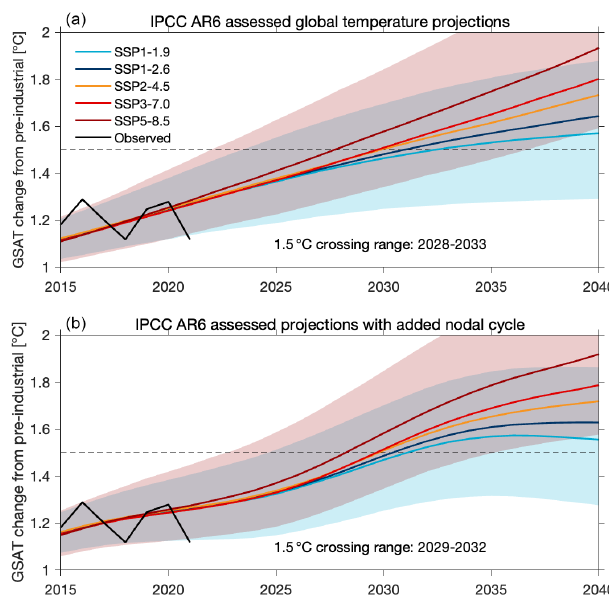
Figure 10. (a) IPCC AR6 assessed trends in GSAT (global sur- face air temperature) for different Shared Socioeconomic Pathways (SSPs). (b) As panel (a) but with a lunar nodal cycle of 0.04K am- plitude, chosen to be approximately an average of the constant and scaled